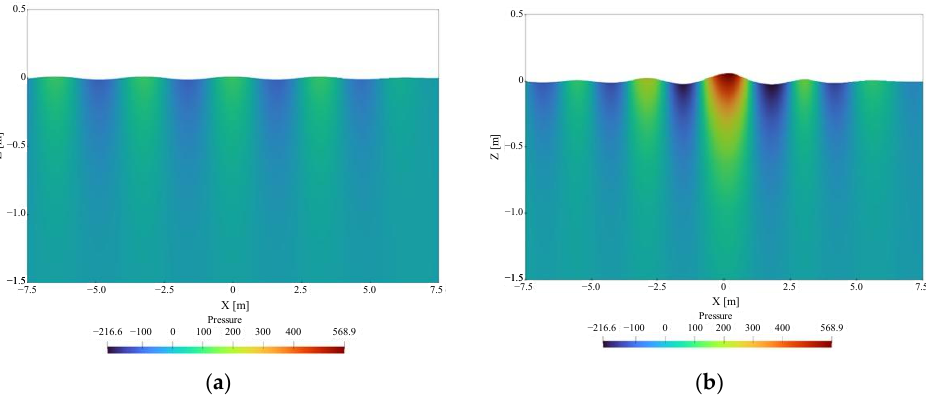
Figure 14. Pressure contours of water phase at y = 0 plane: ( a ) regular wave; ( b ) rogue wave.